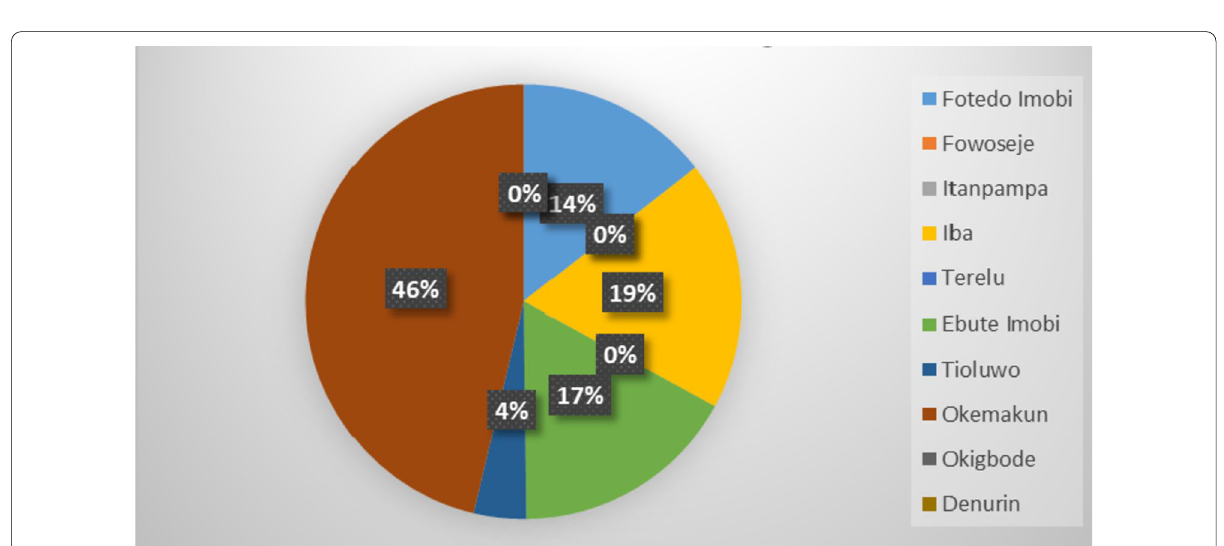
Fig. 3 Use of anti-filarial drug in relation to community